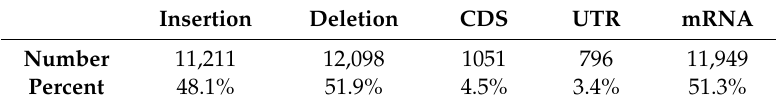
Table 4. Indels distribution in different genomic components.